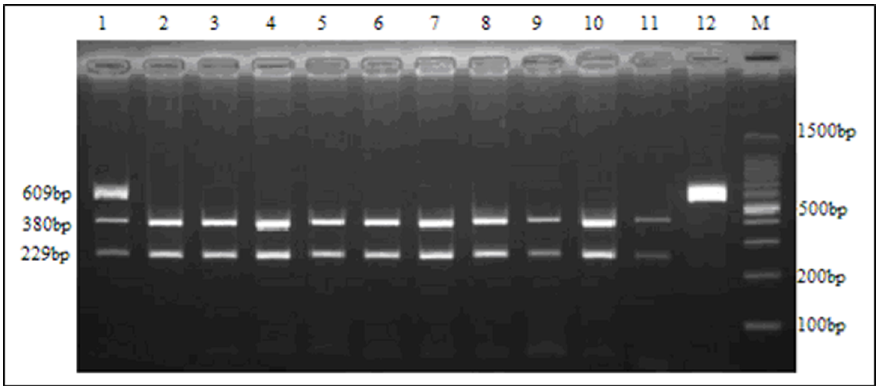
Figure 2. Determination of the rs4769874 genotype by PCR amplification and restriction analysis. When the nucleotide G is present, an Bstu I restriction site is created. Lane 2–11: homozygous GG (380 bp and 229 bp). Lane1: heterozygous GA (609 bp,380 bp and 229 bp). Lane 12: